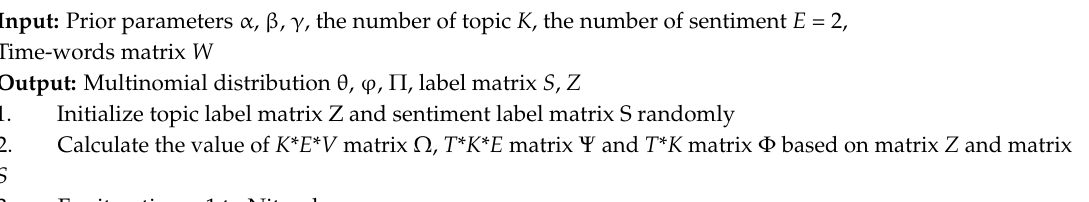
Algorithm 2: Gibbs sampling algorithm flow of